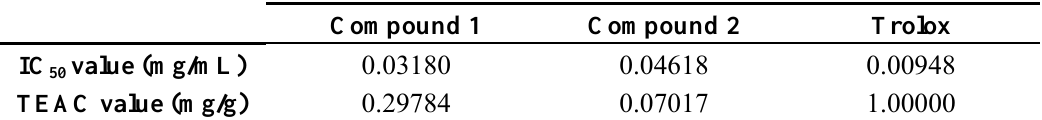
values and TEAC values of compounds 1 , 2 and Trolox with different 50